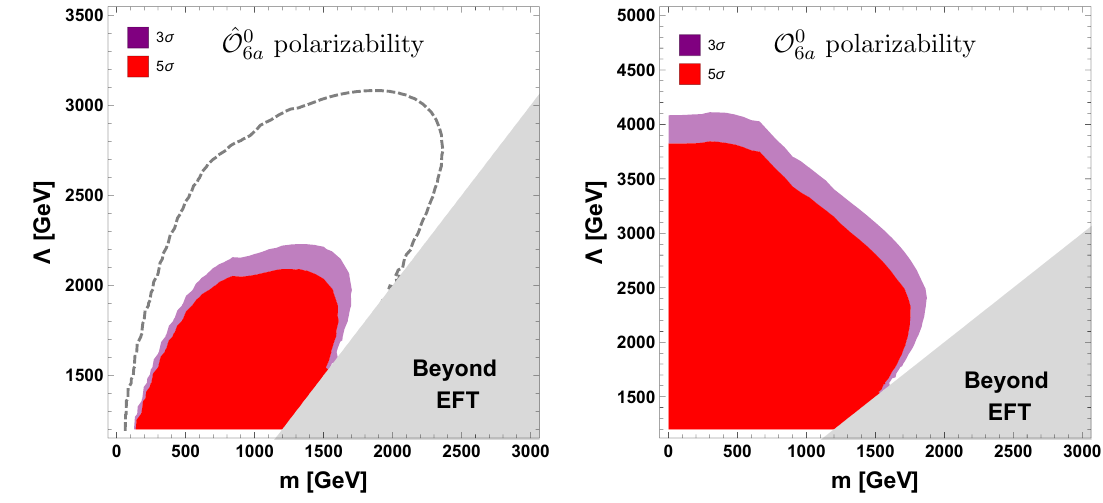
Figure 3 . Same as (cid:12)gure 2, for dimension-8 polarizability ^ O 0 Estimation for the dimension-6 operator O 0